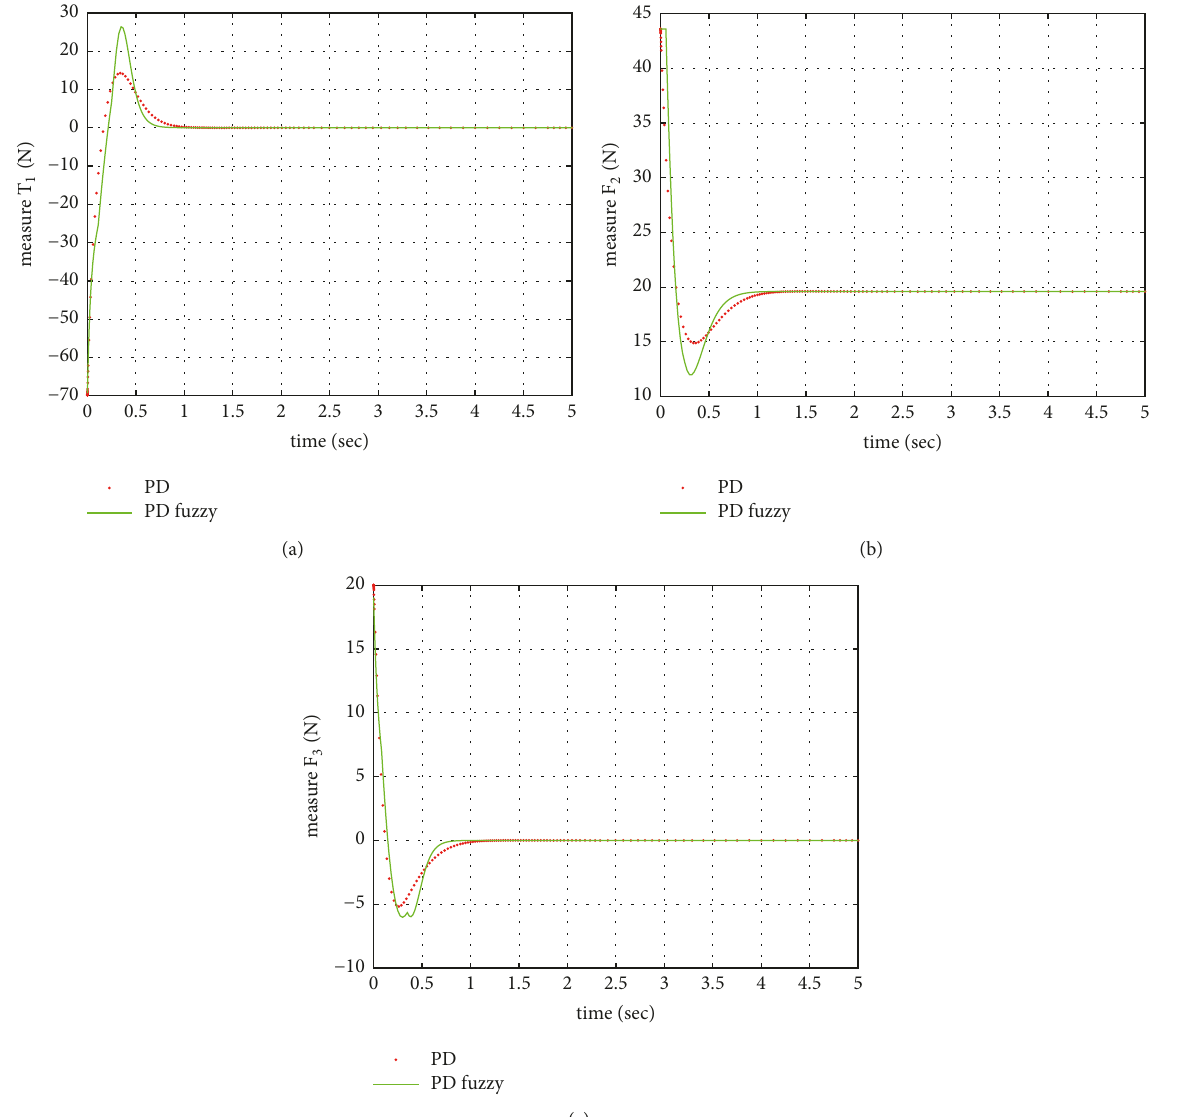
Figure 5: The comparison of the controlling force for optimal fuzzy PD and optimal PD controllers, (a) the controlling force of the first link (revolute), (b) the controlling force of the second link (prismatic), and (c) the controlling force of the third link